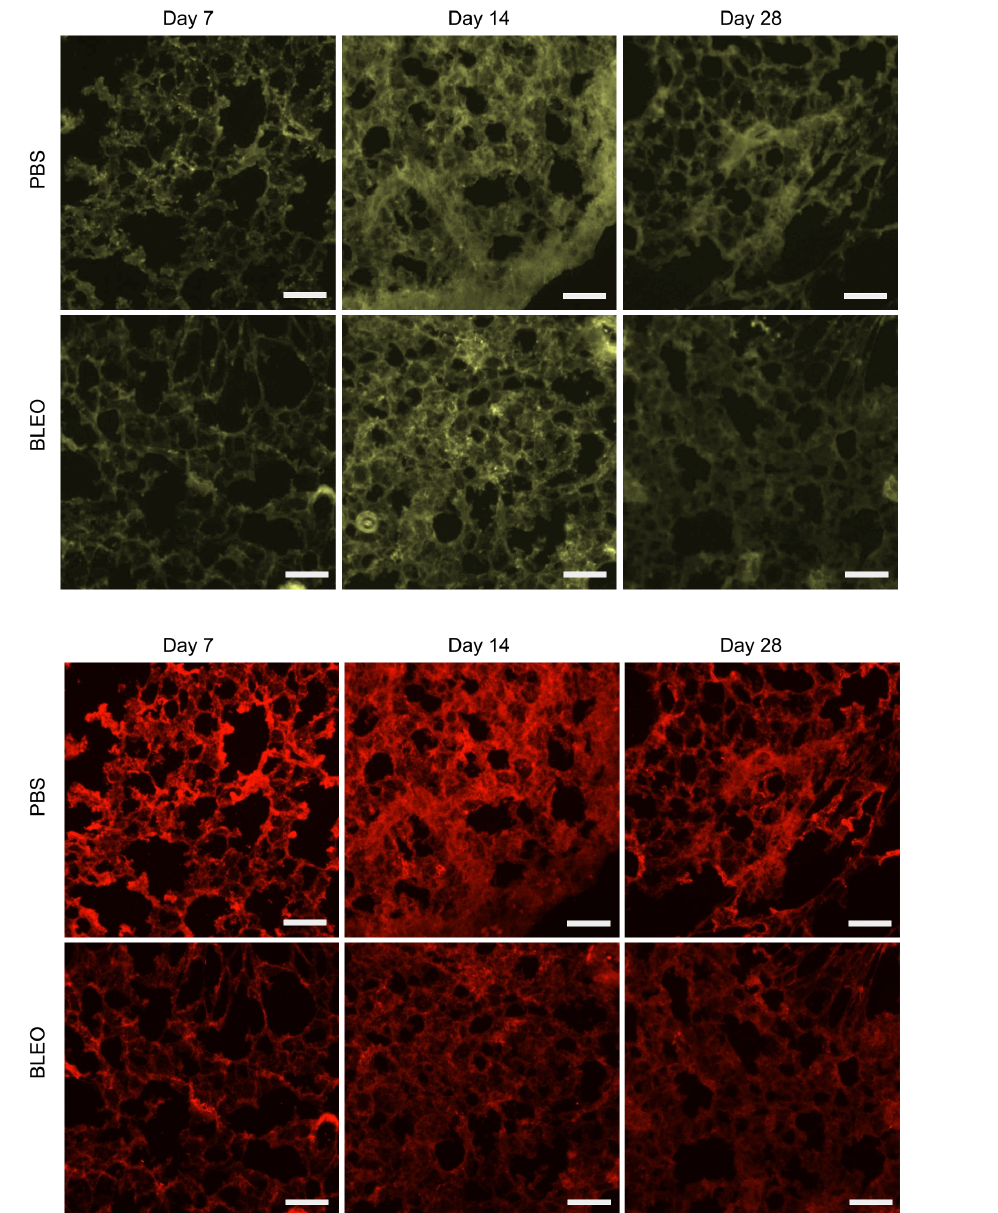
Figure 9. Epifluorescence images of immunostainings of elastin ( top ) and fibronectin ( bottom ) performed on PBS-instilled and bleomycin-instilled decellularized lung ECM. Scale bar = 50 µ